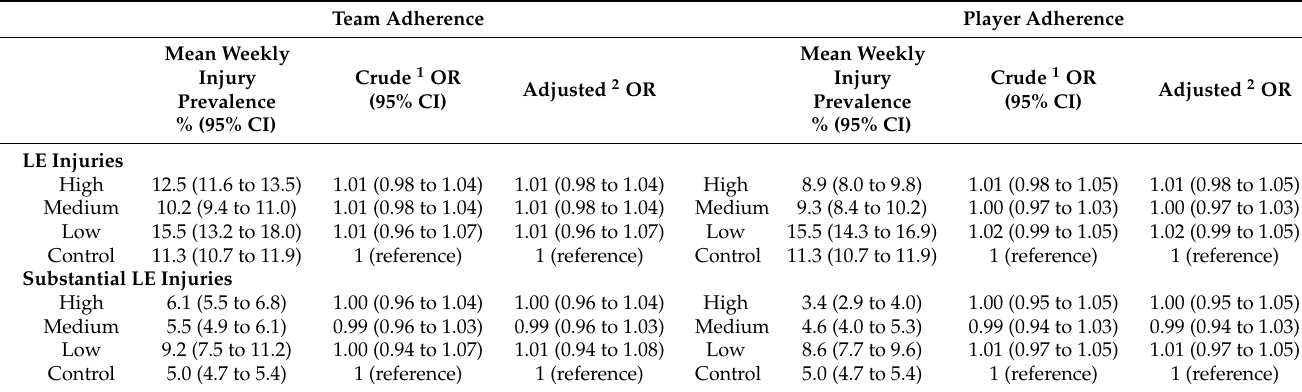
Table 3. Generalized linear mixed model analysis of overuse lower extremity (LE) injury prevalence between intervention adherence groups compared to control group.